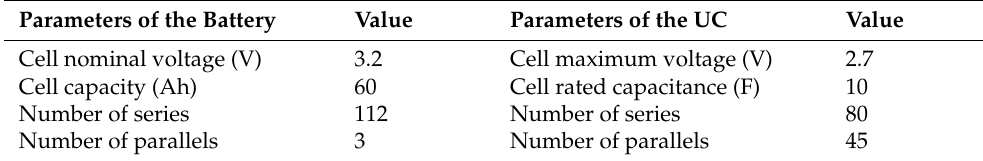
Table 2. Parameters of the battery and UC.